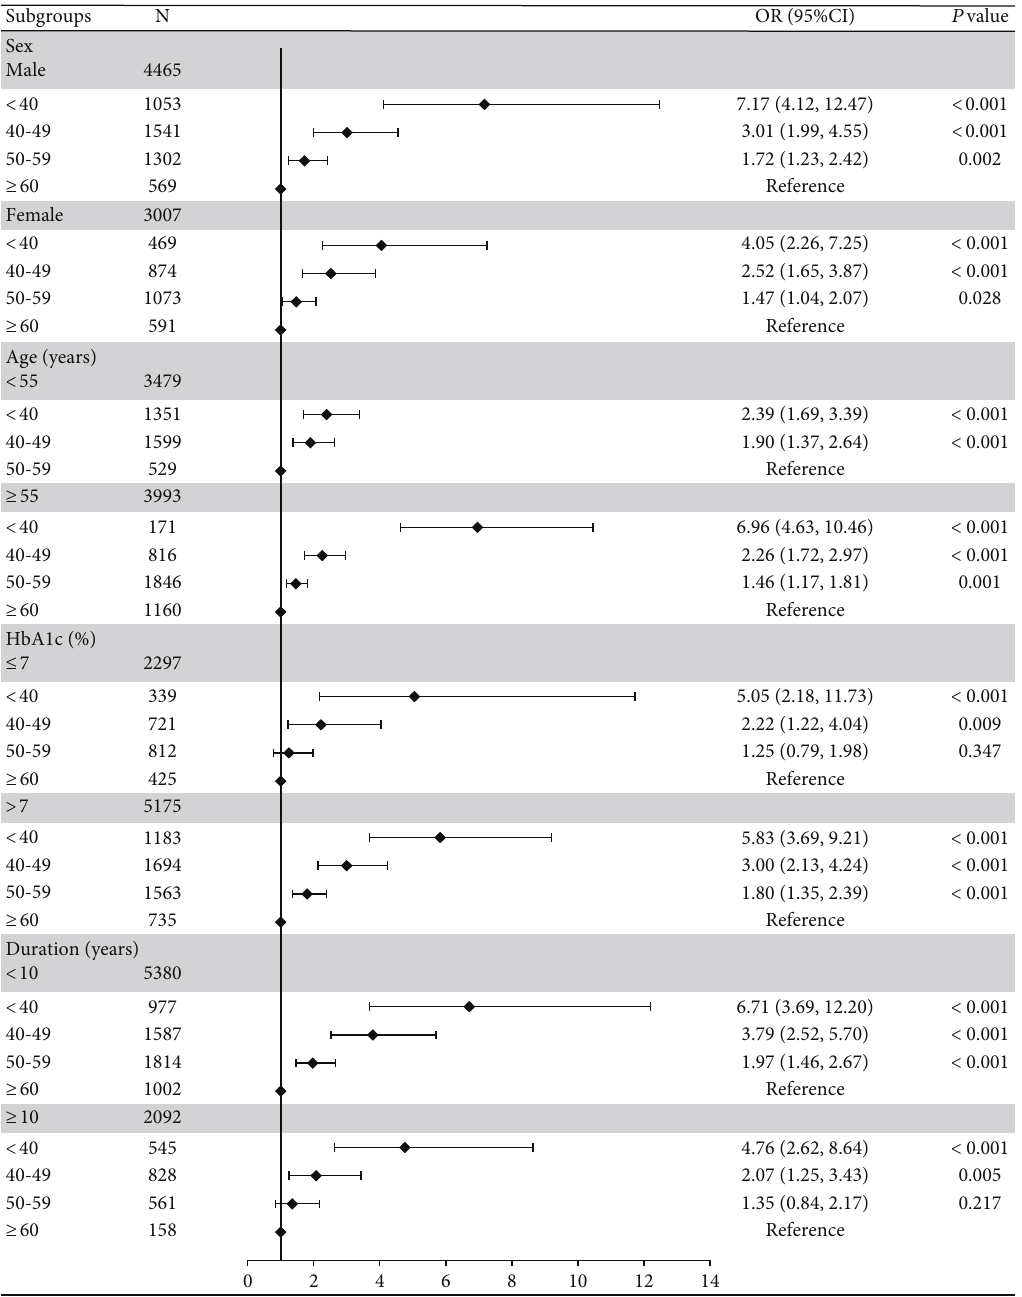
Figure 3: Subgroup analyses of the association of the age of diabetes onset with diabetic retinopathy. Adjusted for age, sex, BMI, HbA1c, diabetes duration, HOMA-IR, UACR, eGFR, education level, family history of diabetes, lifestyle factors (both smoking and drinking status), history of hypertension, history of dyslipidemia, and the use of hypoglycemic drugs, if not strati fi ed. Abbreviations: OR: odds ratio; CI: con fi dence interval; BMI: body mass index; HbA1c: glycated hemoglobin; HOMA-IR: homeostasis model assessment for insulin resistance; UACR: urine albumin-to-creatinine ratio; eGFR: estimated glomerular fi ltration